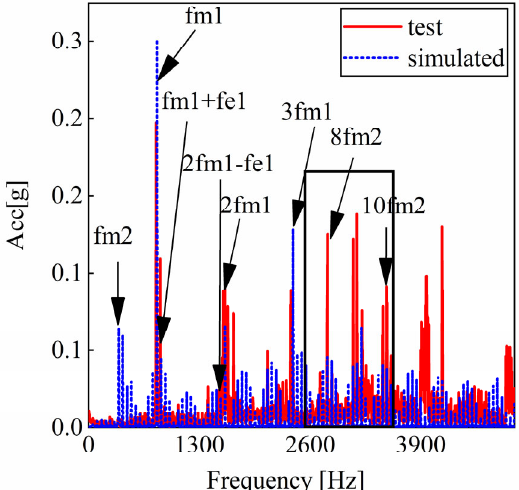
Figure 14. Frequency domain diagram of vibration acceleration of the helical gear in faulty state.